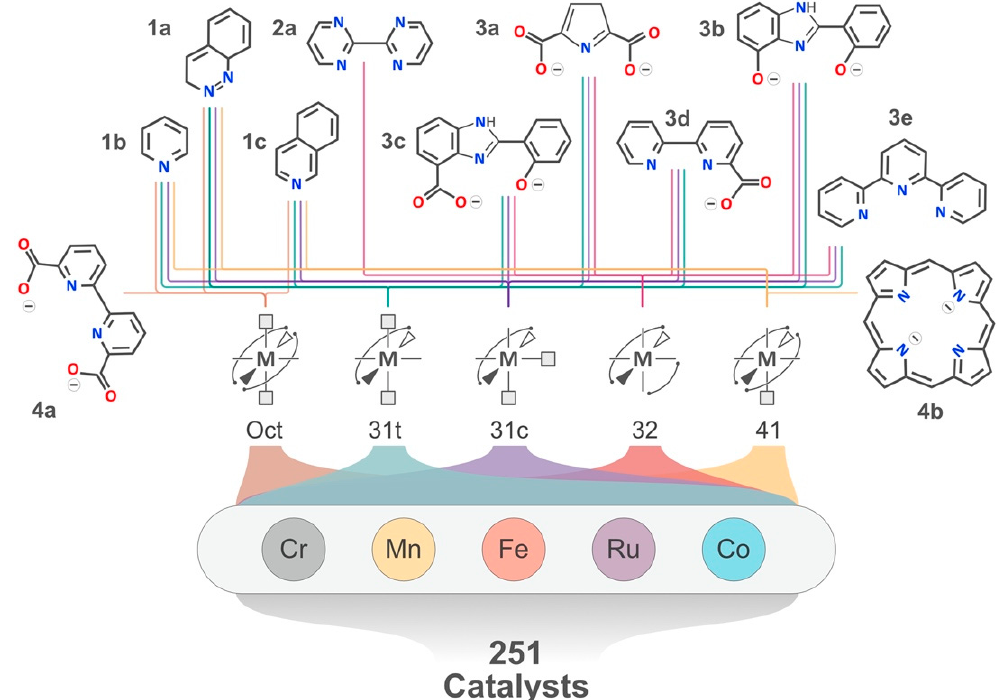
Figure 1. Illustration of the set of catalysts considered to create the datasets required to perform active learning, adapted from Ref. [3] under the terms of the Creative Commons CC-BY license. Each ligand is labelled first by their denticity (i.e. 1, 2, 3 or 4) along with a letter suffix (i.e. a, b, c, d, or e) to distinguish ligands with the same denticity. Monodentate ligands in each of the geometries are represented by grey squares, while the free lines protruding from the metal represent the active site. Where there are two monodentate ligands, they can either be in cis or trans to each other, leading to the labels 31c or 31t, respectively. The 41 geometry contains the porphyrin ligand 4a along with one of the three monodentate lig- ands.